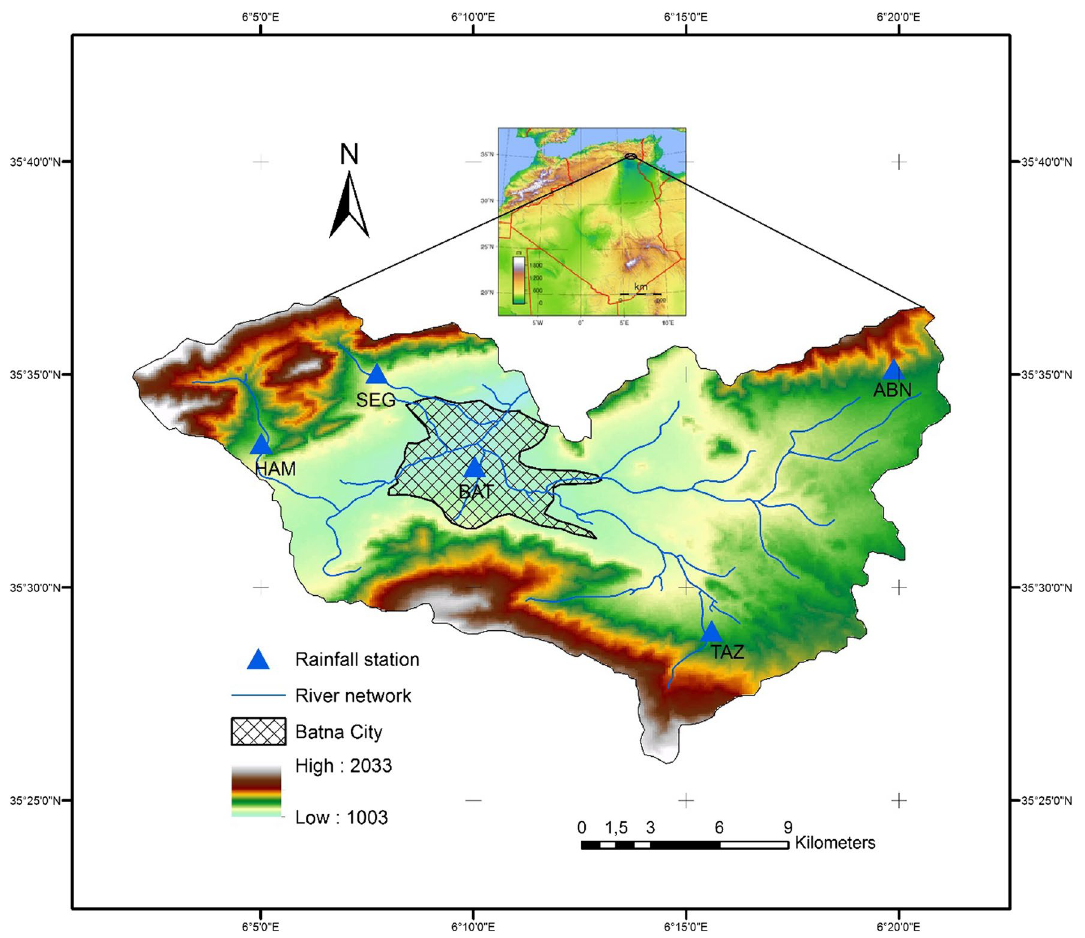
Fig. 1 Geographical map of the Oued El Gourzi Watershed and the five